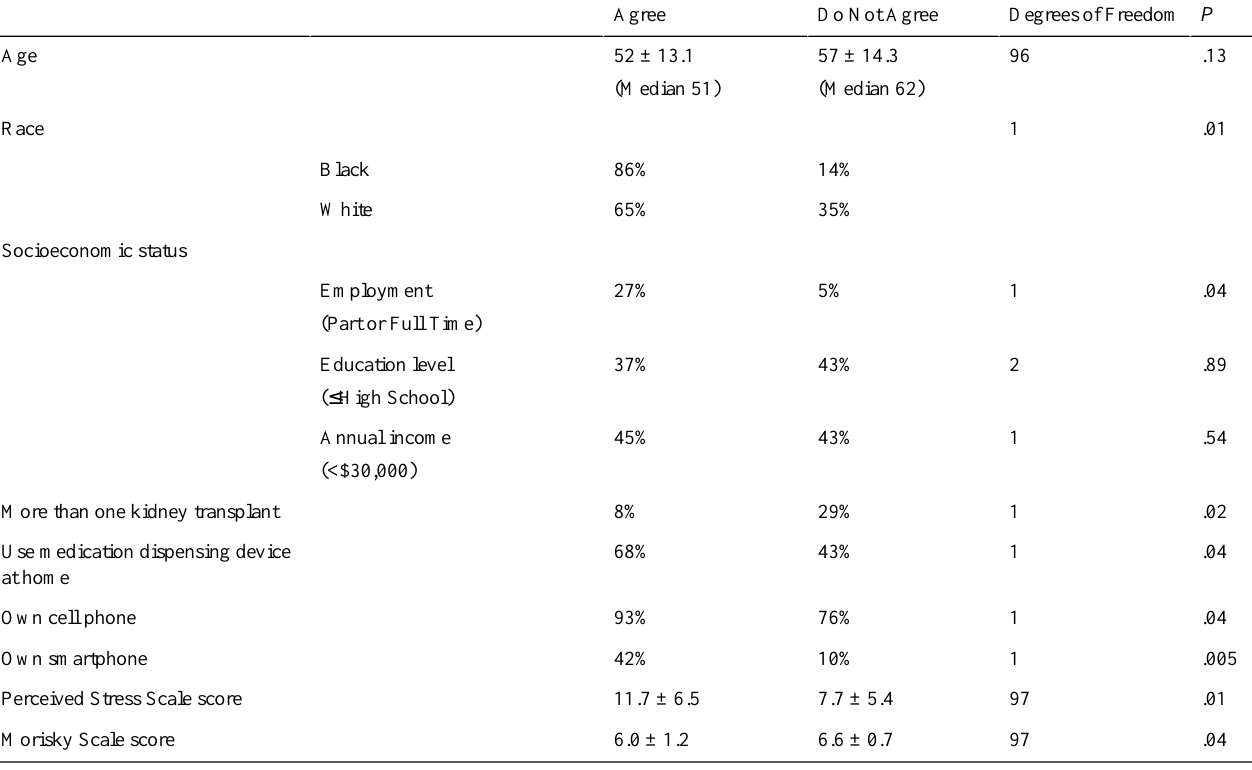
Table 4. Comparisons of patients who do versus do not favor use of mHealth devices.